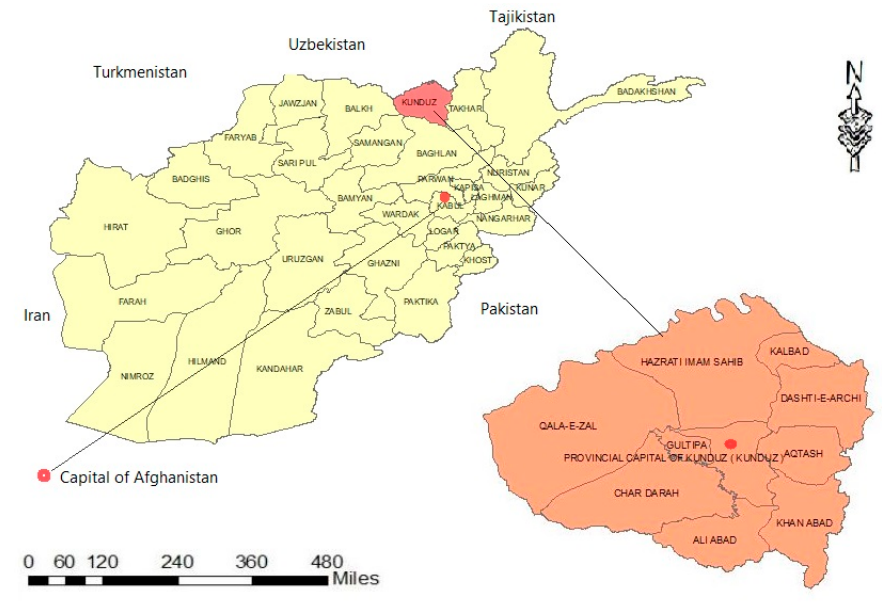
Figure 1. Study area location (Kunduz Province–Afghanistan).